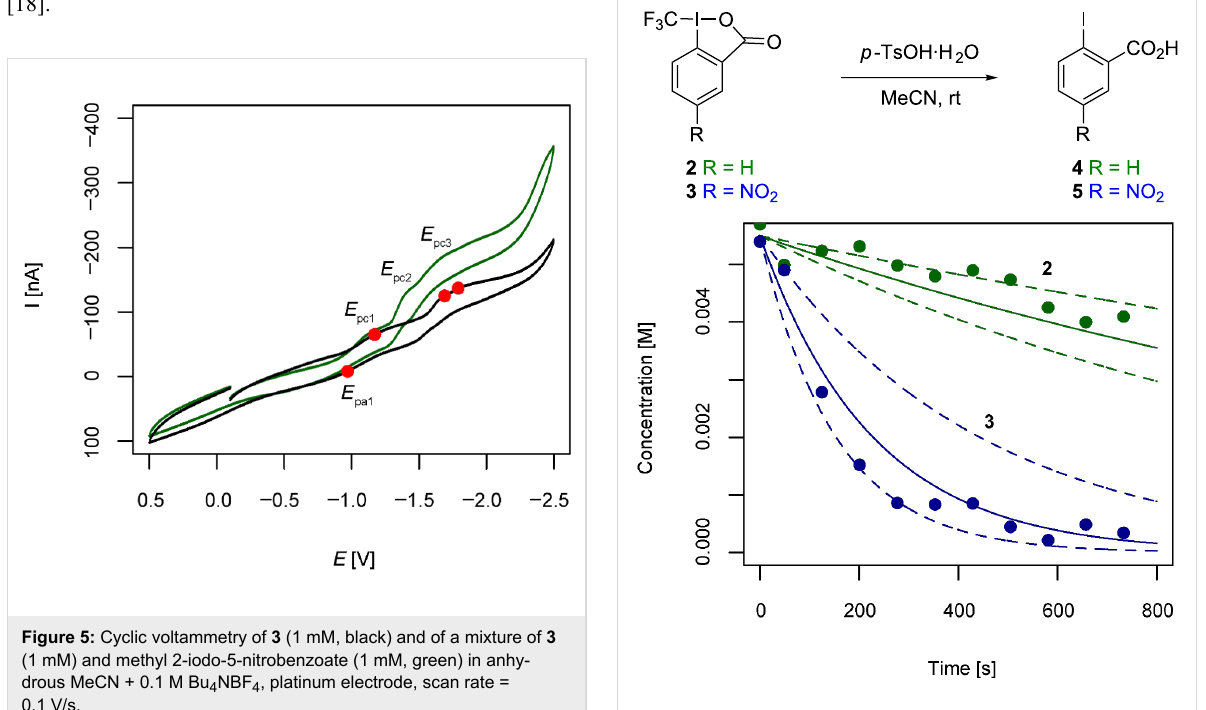
identified as the reduction of the hypervalent bond. Therefore, the more negative waves most likely correspond to the reduc- tion of the nitro group and/or further reduction of iodine as reported in CV studies carried out on bis(acetoxy)iodobenzene [18].